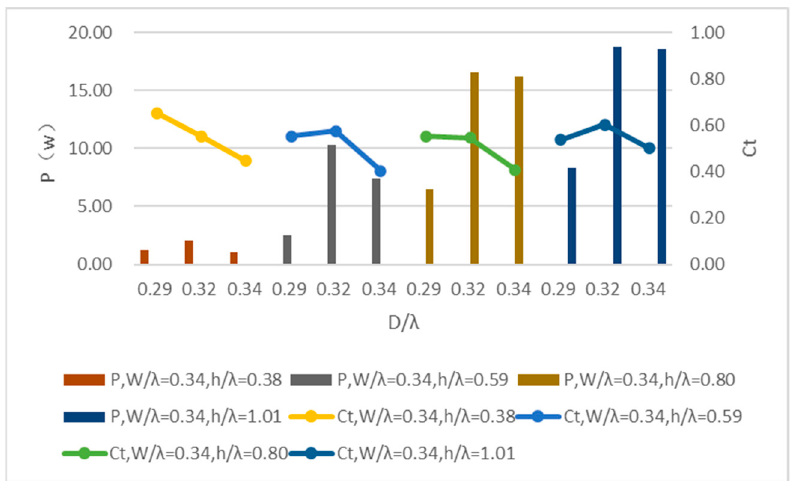
Figure 14. Physical experiment data map. Figure 14. Plot of experimental data with D/ λ as variable.